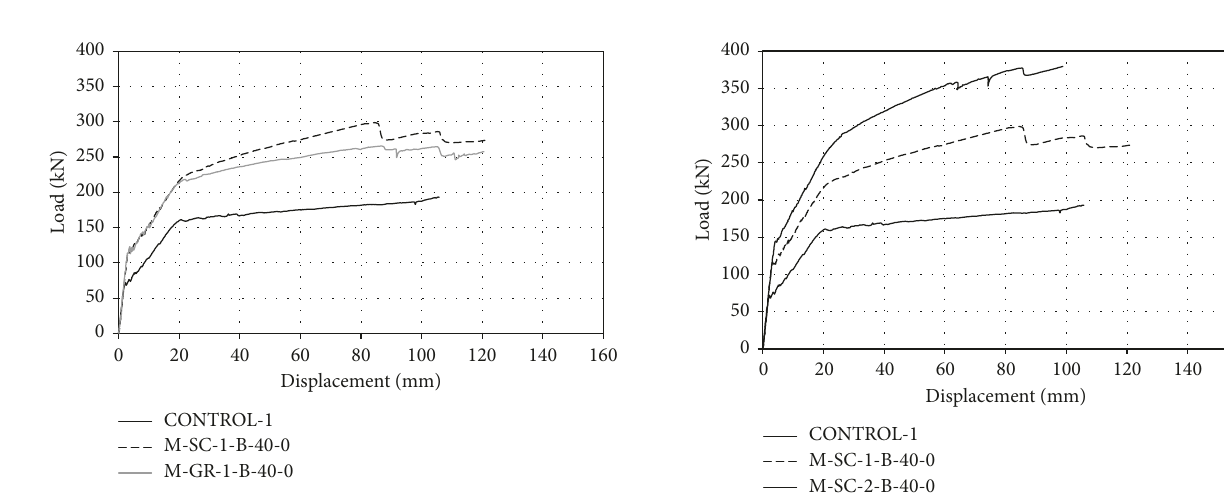
Figure 17: Strengthening effect w.r.t. surface treatment.